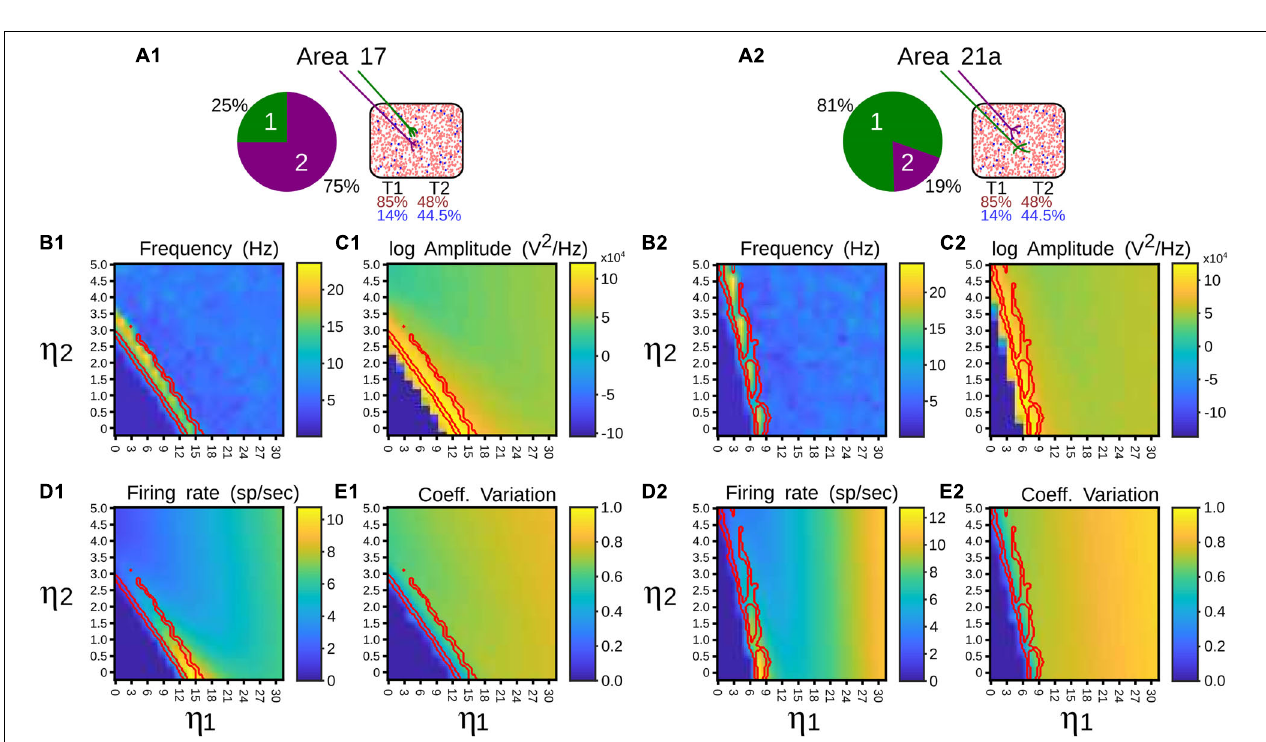
FIGURE 5 | Quantitative outputs for a pulvinar network whose neurons receive projections from areas 17 (1) and 21a (2). Factors η 1 and η 2 amplify corticothalamic projections of terminal types 1 and 2, respectively. (A) Distribution and number of contacts to excitatory and inhibitory pulvinar neurons of terminal types 1 and 2 for cortical areas. Red and blue letter colors indicate excitatory and inhibitory percentages, respectively. Terminal types 1 and 2 are represented by colors green and purple, respectively. (B) Frequency (Hz), (C) Amplitude (V 2 /Hz), (D) Firing rate (sp/s), (E) CV. Red lines in panels (B–E) indicate zones where alpha rhythms are